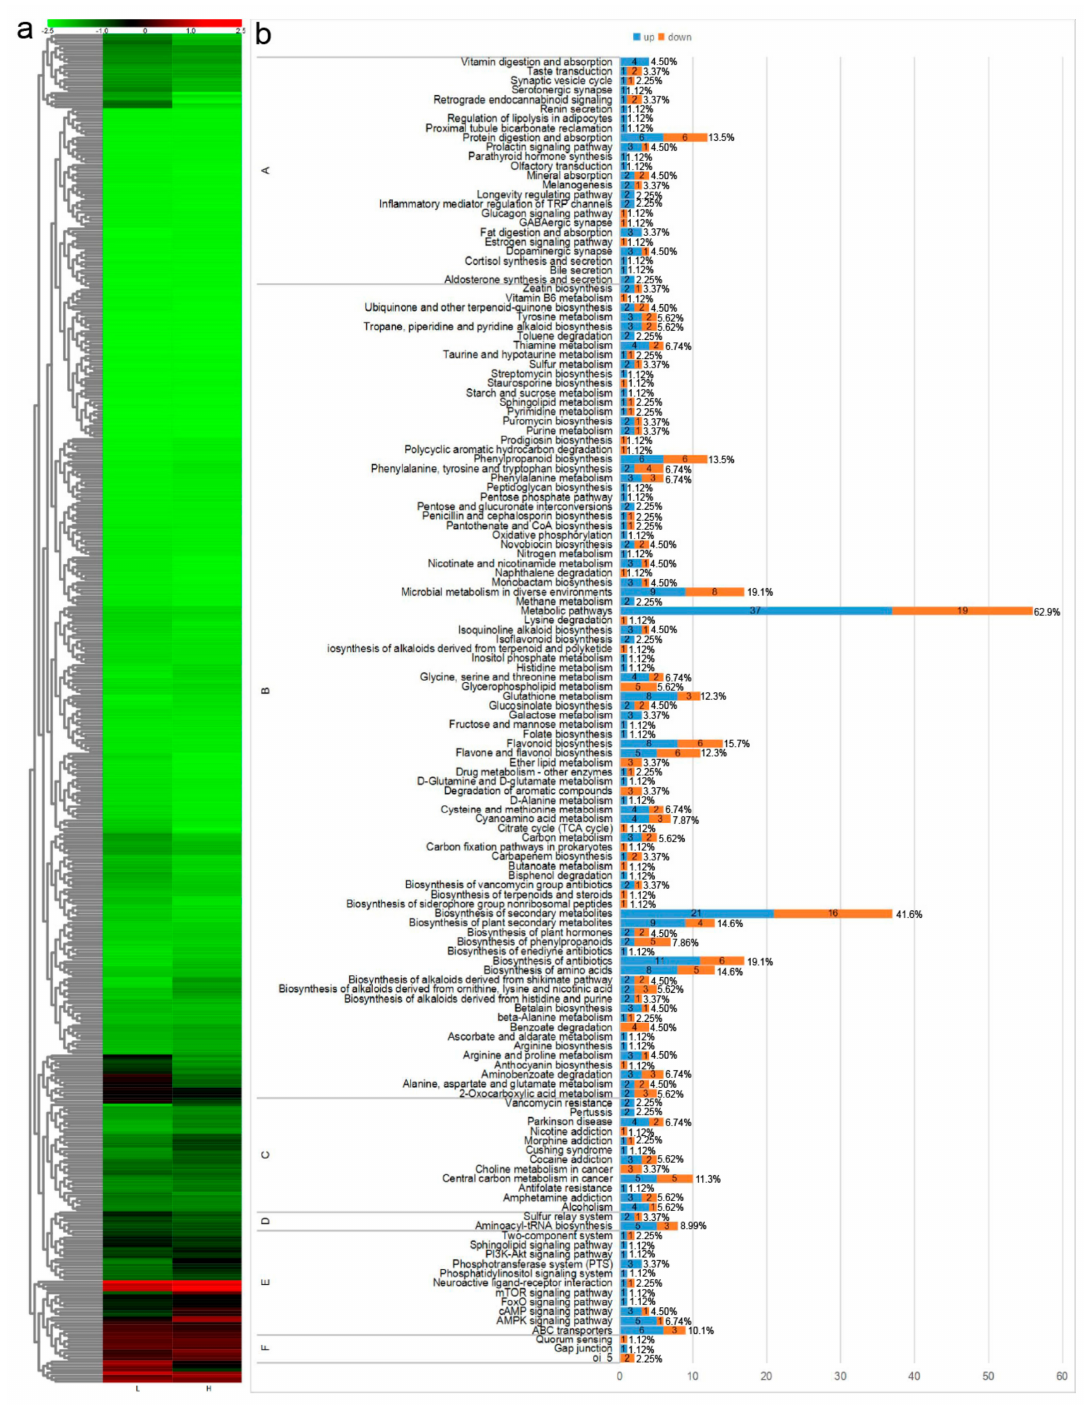
Figure 3. ( a ), Cluster diagram of the metabolite components of the E. senticosus high and low DNA methylation groups. The ordinate represents the metabolite components, and the abscissa represents di ff erent samples. Red represents a relative increase in metabolites, and green represents a decrease in the relative amounts. ( b ), KEGG classification diagram of the metabonomic characteristics of metabolites with significant di ff erences between the E. senticosus high and low DNA methylation groups. The ordinate is the name of the KEGG metabolic pathway, and the abscissa is the number of metabolites annotated to the pathway, and the proportion of that number to the total number of metabolites annotated is given in brackets. A is organismal systems, B is metabolism, C is human diseases, D is genetic information processing, E is environmental information processing, F is cell